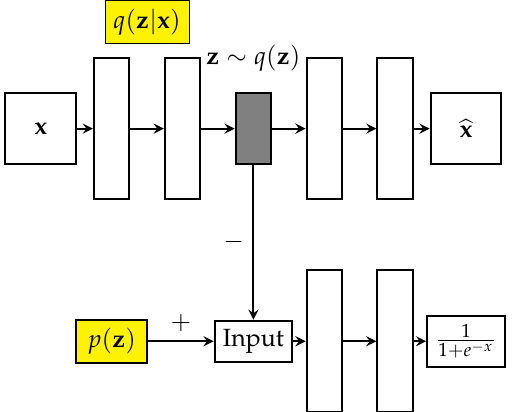
Figure 10. Two paths in the Adversarial Autoencoder : Top path refers to the standard autoencoder configuration that minimizes reconstruction error. The bottom path constitutes of an adversarial network that ensures an approximation of the user input defined samples from distribution p ( z ) , and the latent or code vector distribution, provided by q ( z | x )